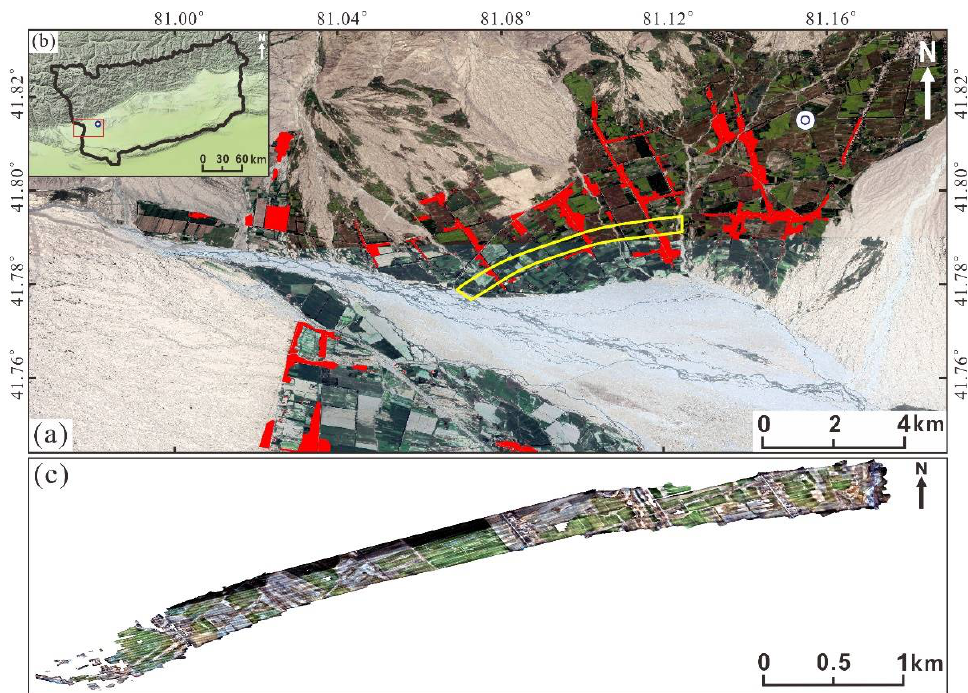
Figure 1. Study area. ( a ) Details of the Baicheng earthquake, as shown in an optical image obtained using Google Earth Engine (https://earthengine.google.com/), and accessed on 10 October 2021. Location of the hypocenter, drawn as a white circle. The red part is the building area, and the yellow polygon is the UAV operation range; ( b ) Location of the Baicheng county, drawn as a black polygon. The blue circle represents the location of the Baicheng earthquake. The red box represents the position of ( a ) in ( b ); ( c ) UAV images.